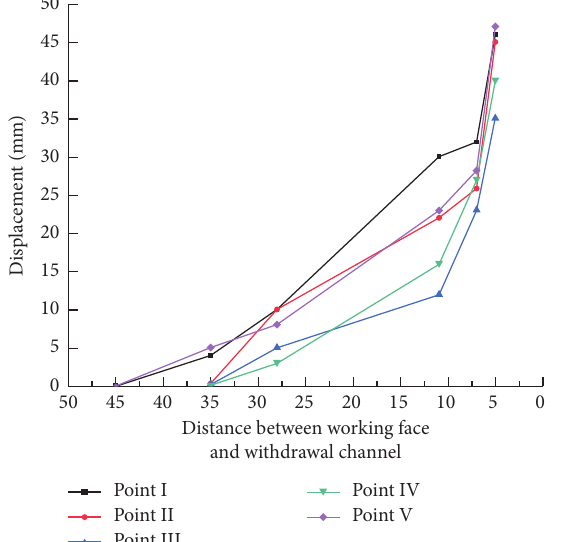
Figure 24: Roof and floor displacement variations in auxiliary withdrawal channel.